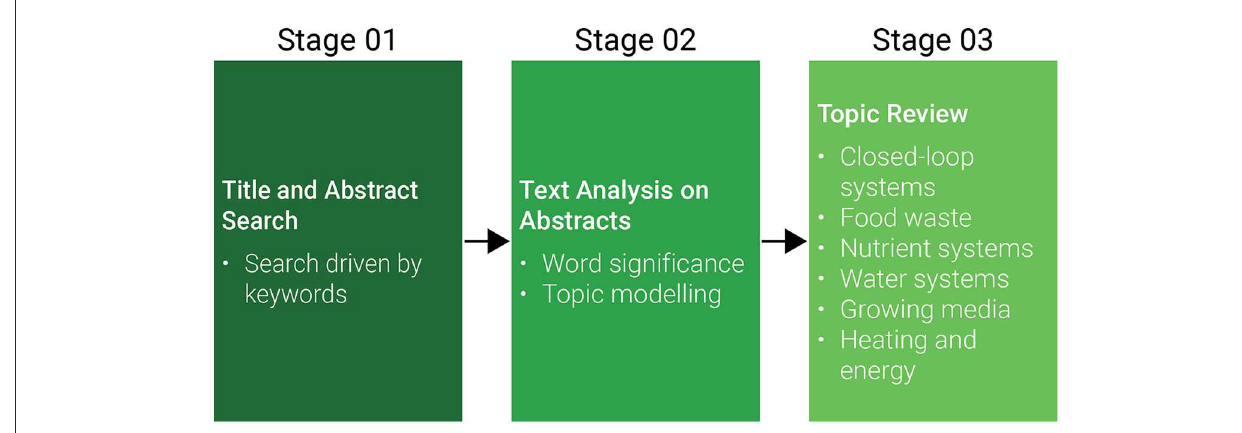
FIGURE1 An illustration of the meta-research approach of this systematic review